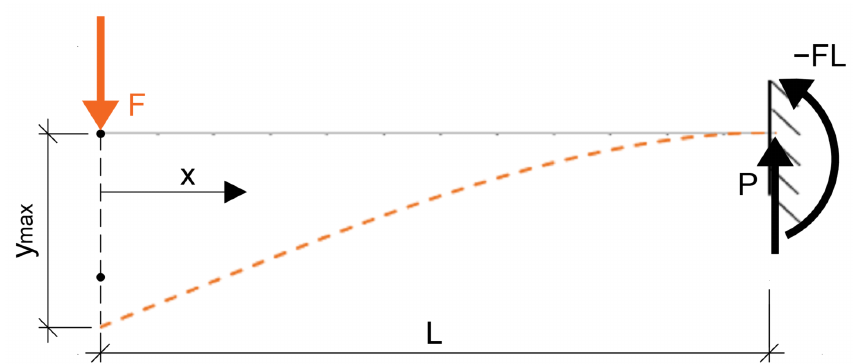
Figure 9. Schematic of the analytical load test used. Table 2. Selected material characteristics of foam concrete [1 – 6] .